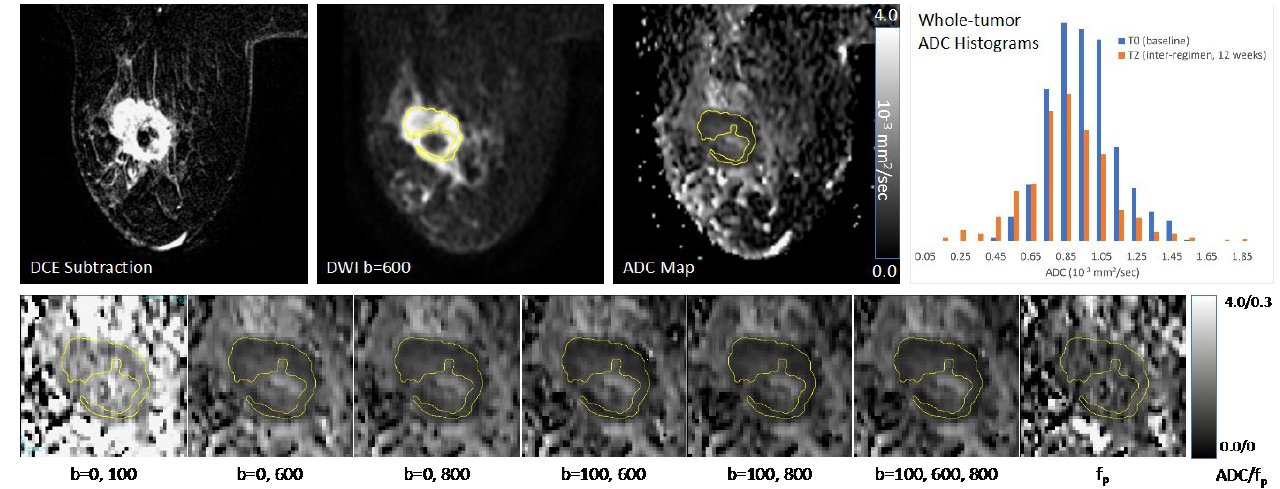
Figure 3. Sample images and diffusion maps from one non-pCR patient at baseline. The top row shows matched slices from the dynamic contrast-enhanced (DCE) early subtraction image, the diffusion-weighted image (DWI), and the quantitative apparent diffusion coefficient (ADC) map. Histograms are shown for the whole-tumor ADC values for this pre-treatment (T0) scan and the patient’s mid-treatment timepoint (T2) MRI. The subject showed a steady decrease in tumor volume both on DCE and DWI, but no recovery towards normal tissue ADC values was observed for the mean ADC. The bottom row shows the tumor region ADC maps for all b -value combinations (units 10 − 3 mm 2 /s) plus the f p map.